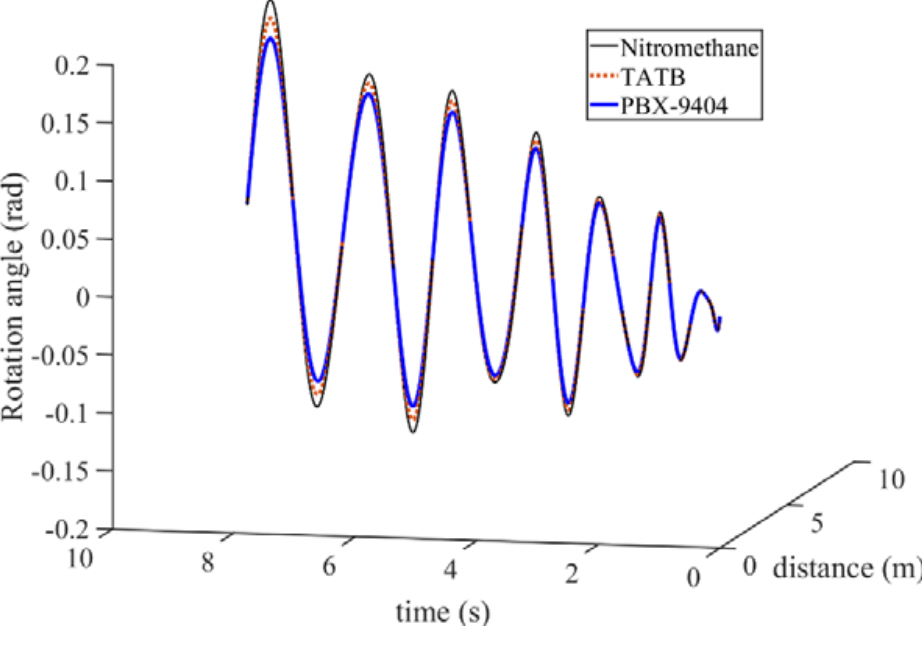
Figure 10. Impact of explosive type on rotation